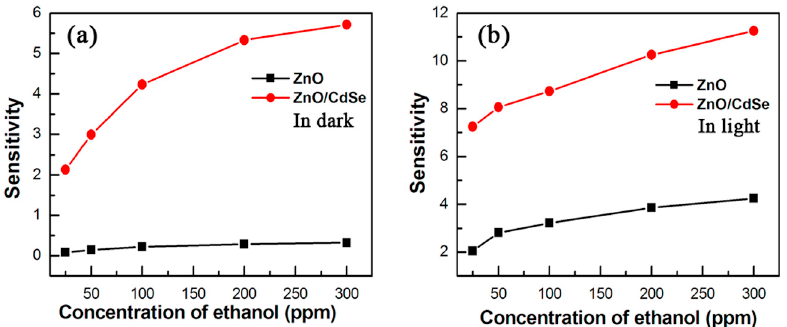
Figure 46. Responses of ZnO nanorod and ZnO/CdSe HS-based sensors to ethanol vapor of different concentrations ( a ) in the dark and ( b ) under visible light illumination. Reproduced with permission from [71].